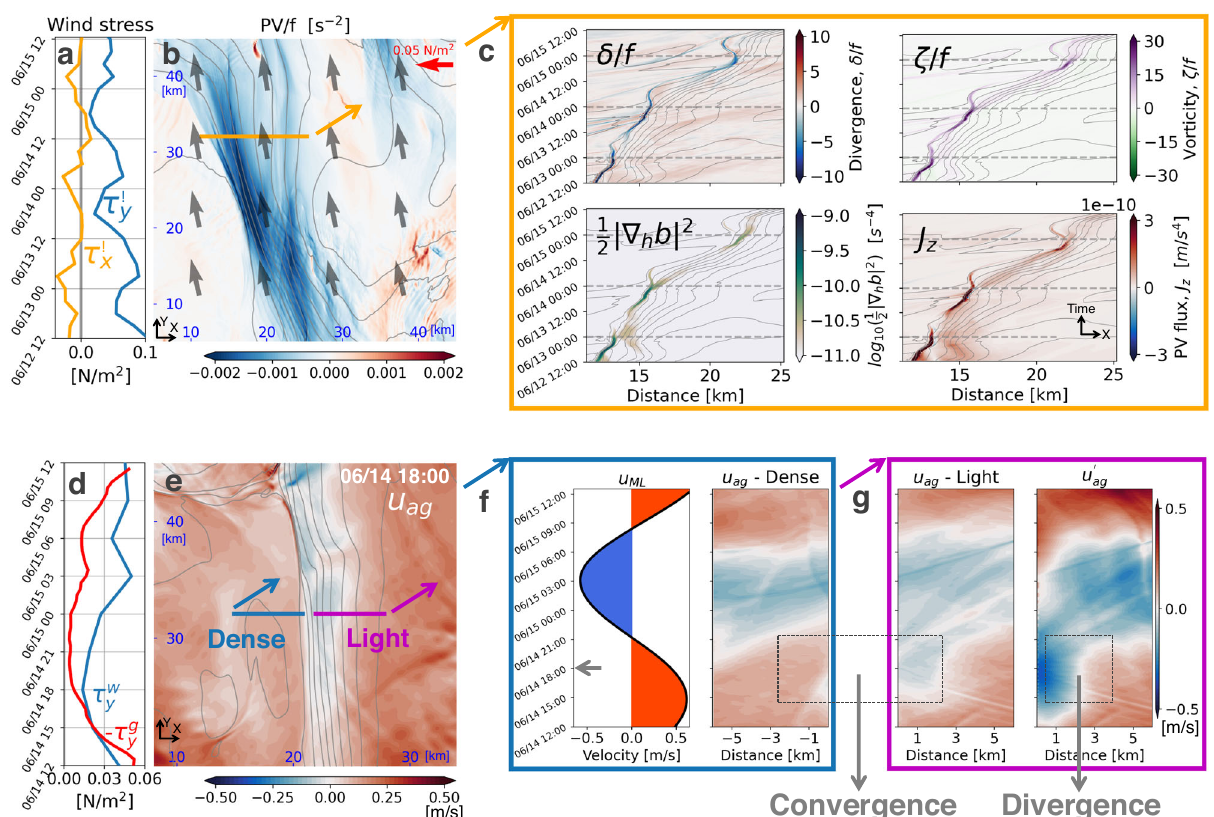
Fig. 5 | Inertially modulated frontogenesis and convergence. a Time series of the surface wind stress over the L3 domain. b Surface PV (color), wind stress (vectors) and density(contours)that areaveraged between06/1212:00and 06/ 15 12:00 UTC. c Hovmöller diagrams of surface normalized divergence ( δ / f ), horizontal buoyancy gradient squared (1/2 ∣ ∇ h b ∣ 2 ), and PV fl ux ( J z ), which are calculated along the orange line in b (the same line in Fig. 3e). d Comparison betweenthewind stress τ w y andminus the geostrophicstress τ g y atthe frontover one inertial period. τ g y and τ w y are averaged over a front-following section (the fi rst 2km of the magenta section in e ). e Across-front ageostrophic velocity u The velocity is averaged over the top 5m. The snapshot is taken at 06/14 18:00 UTC (marked by the arrow in f ). Two front-following sections are plotted for each side of the front. f Velocity evolution over one inertial period on the dense